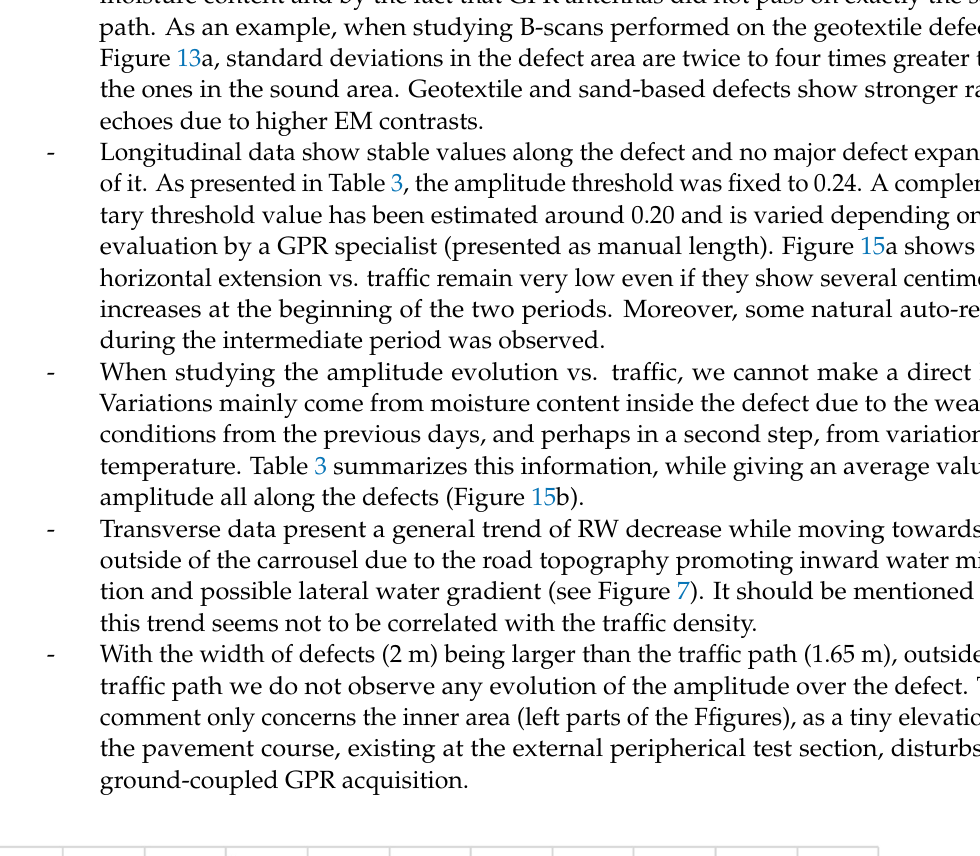
Figure 14. 2.6 GHz Norm. RW amplitudes on tack-coat free (I-13) in the ( a ) long. and ( b ) transv. direction vs. K loadings. Table 3. Detected characteristics of defect zones from 2.6 GHz longitudinal B-scans.